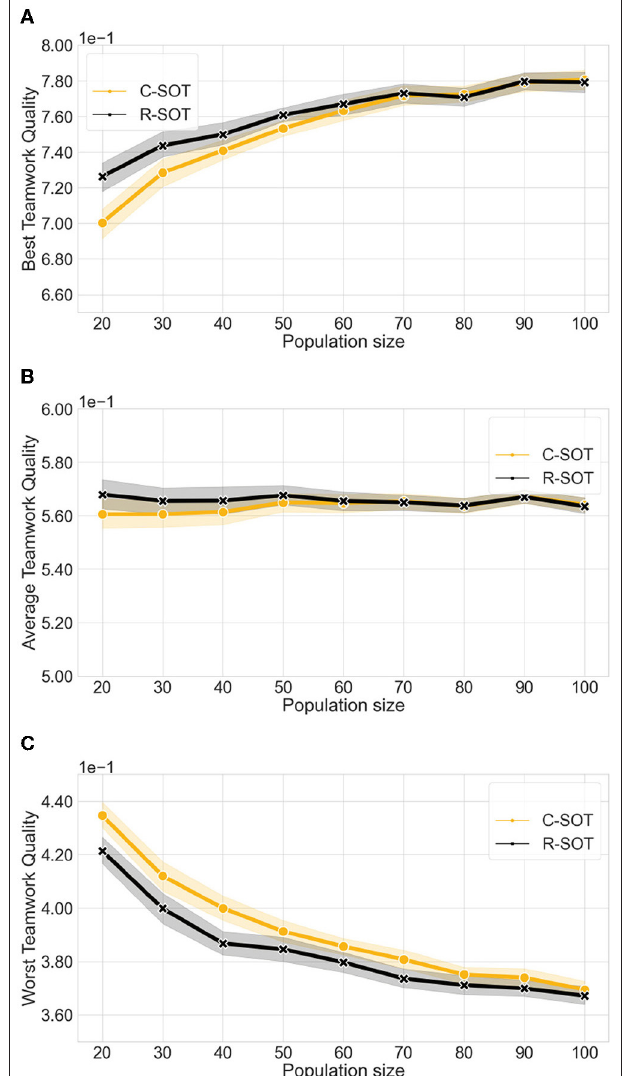
FIGURE 4 | Comparison of the best and worst teamwork quality between two bottom-up models (C-SOT and R-SOT) with different population sizes. The x axes show the different simulated population sizes per hackathon in the ∈ [20,100] range. We observe that the best teamwork quality for both bottom-up models improves as the population grows from 20 to 90 individuals, and workers have more choice of teammates, reaching stability with populations of more than 90 and maintaining a best teamwork quality of ≈ 0.77 in both models. However, the worse teamwork quality also decreases steadily in both models lowering from ≈ 0.43 to ≈ 0.37 as the population grows indicating that large populations are not always beneficial to the performance of all teams. (A) Best teamwork quality for C-SOT and R-SOT with different population sizes . (B) Average teamwork quality for C-SOT and R-SOT with different population sizes . (C) Worst teamwork quality for C-SOT and R-SOT with different population sizes